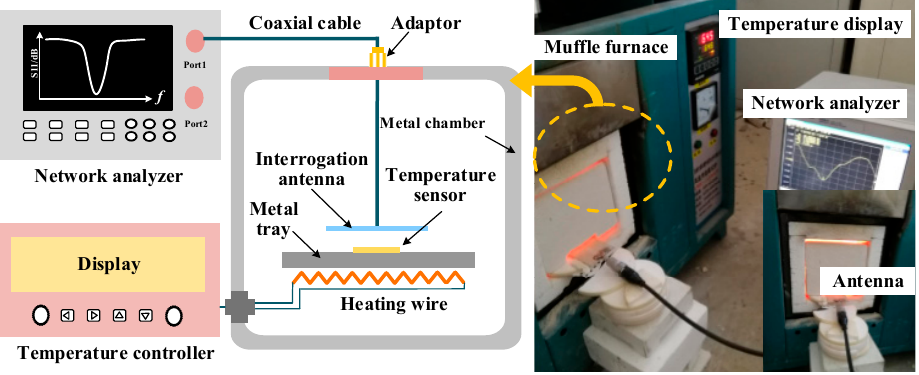
Figure 6. Measurement system of the temperature sensor.